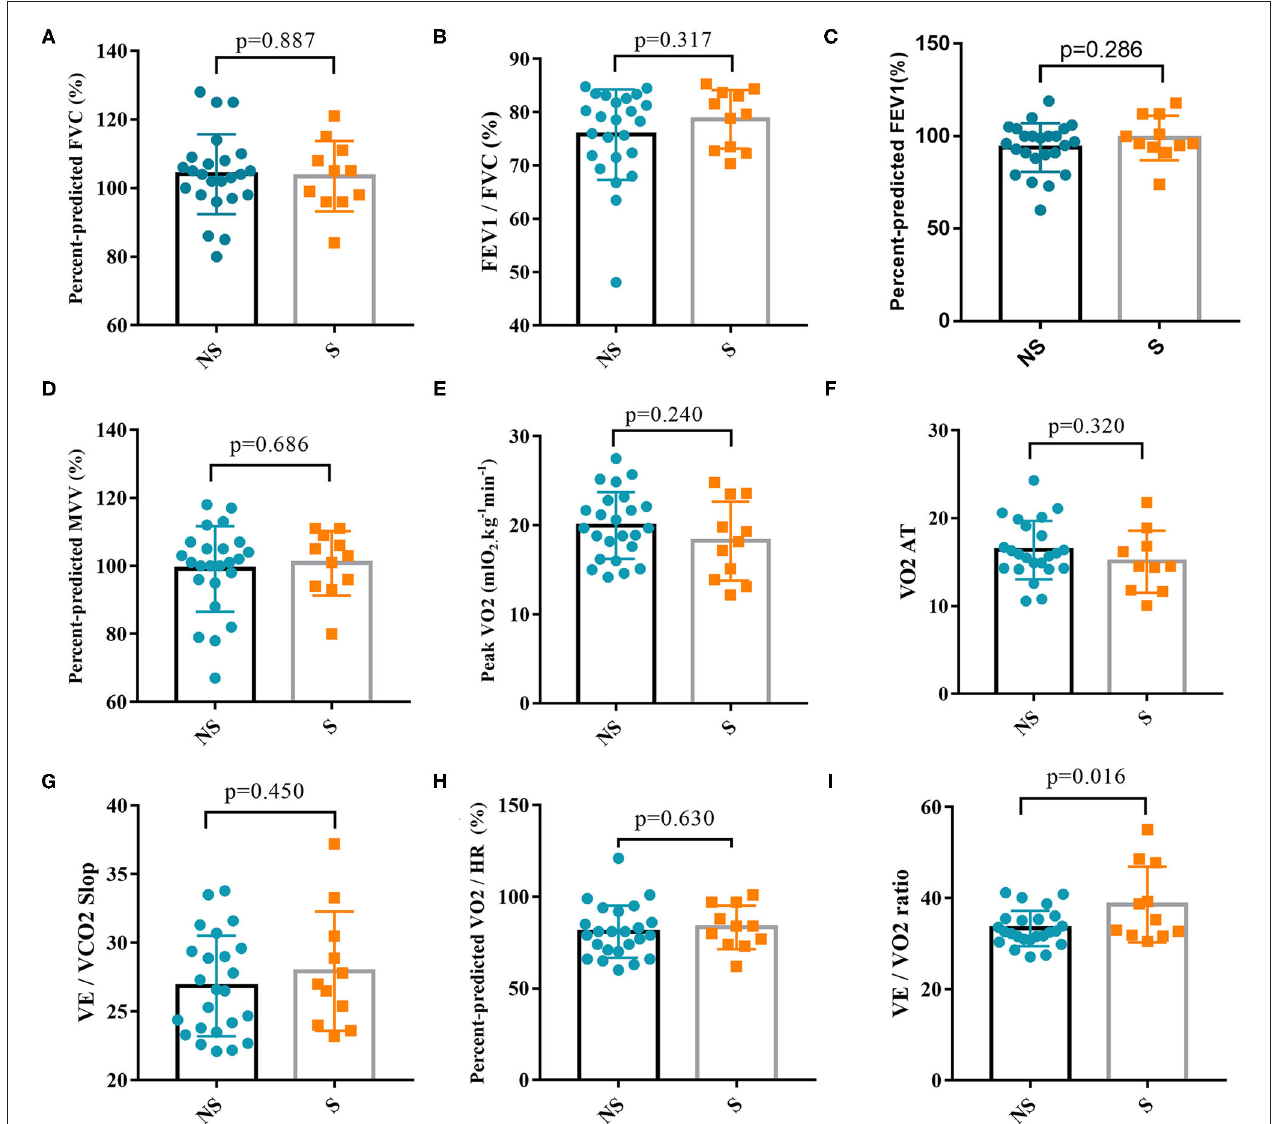
FIGURE 4 | Comparison of cardiopulmonary exercise test parameters between the severe group and non-severe group. (A) Percent-predicted FVC between the two groups. (B) FEV1/FVC between the two groups. (C) Percent-predicted FEV1 between the two groups. (D) Percent-predicted MVV between the two groups. (E) Peak VO2 between the two groups. (F) VO2 AT between the two groups. (G) VE/VCO2 Slop between the two groups. (H) Percent-predicted VO2/HR between the two groups. (I) VE/VO2 ratio between the two groups. FVC, forced vital capacity; FEV1, forced expiratory volume in one second; MVV, maximal voluntary ventilation; Peak VO2, peak oxygen uptake; AT, anaerobic threshold; VE, minute ventilation; HR, heart rate; VCO2, carbon dioxide production; NS, non-severe; S,